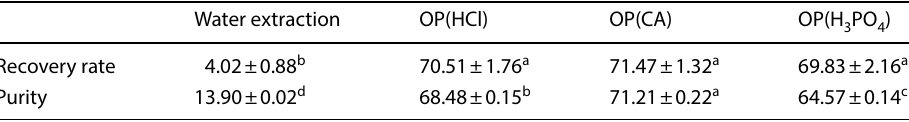
Different superscripts (a–e) indicate significant differences ( p < 0.05)